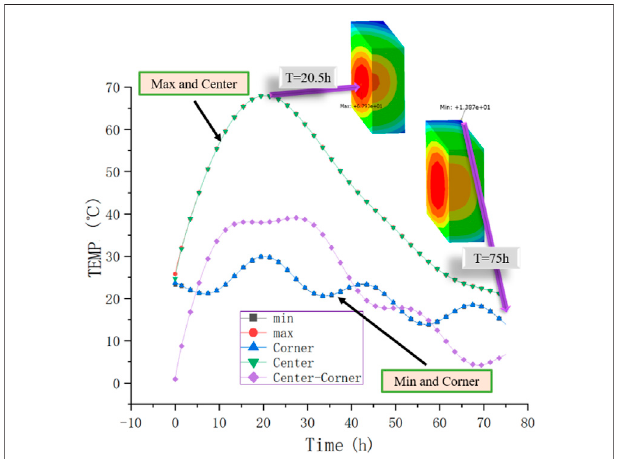
FIGURE 14 | Temperature and temperature extremes history curve.